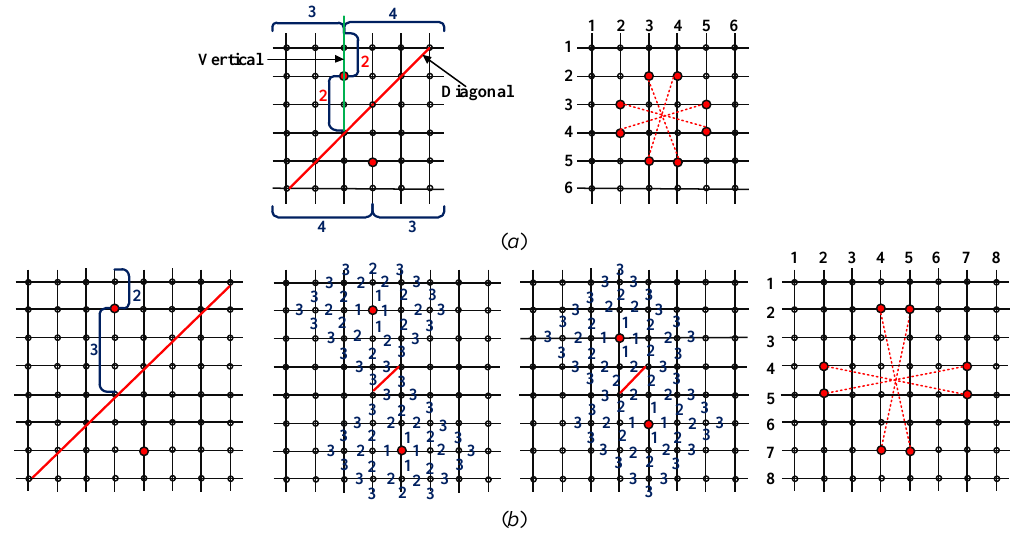
Figure 11. Center rule (K = 2): ( a ) 6 × 6 intersections; ( b ) 8 × 8 intersections.